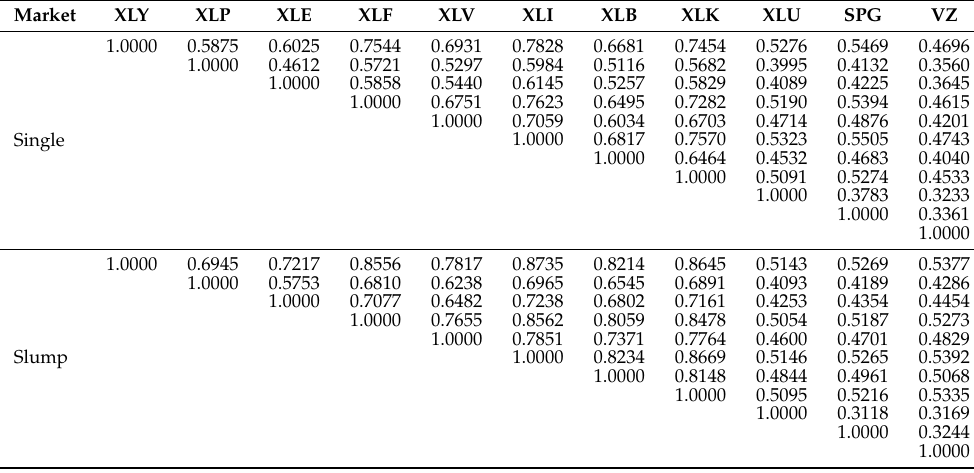
Table A1. Conditional correlation coefficients of security